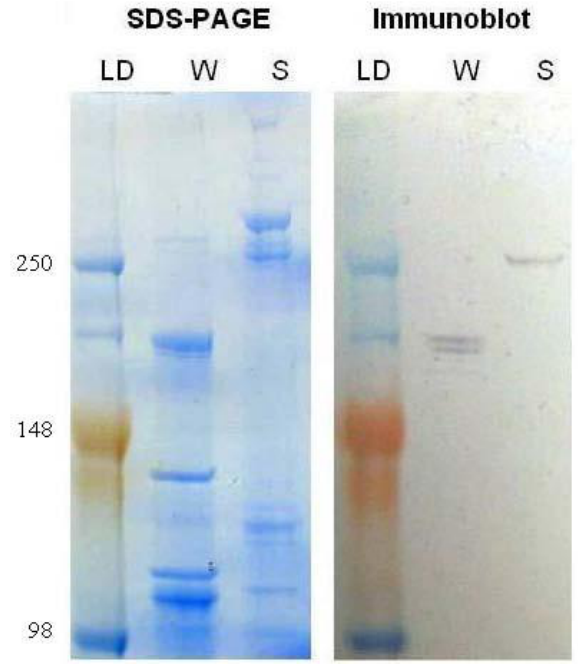
Figure 4. Total protein was extracted from the worker and soldier head tissue samples and subjected to sodium dodecyl sulfate polyacrylamide gel electrophoresis (SDS-PAGE), one gel was stained with SimplyBlue (Invitrogen), left, and the other was transferred to a membrane and immunoblotted for myosin heavy chain, right. Lanes from left to right are as follows: molecular weight ladder (LD; 250, 148 and 98 kDa), worker (W), and soldier